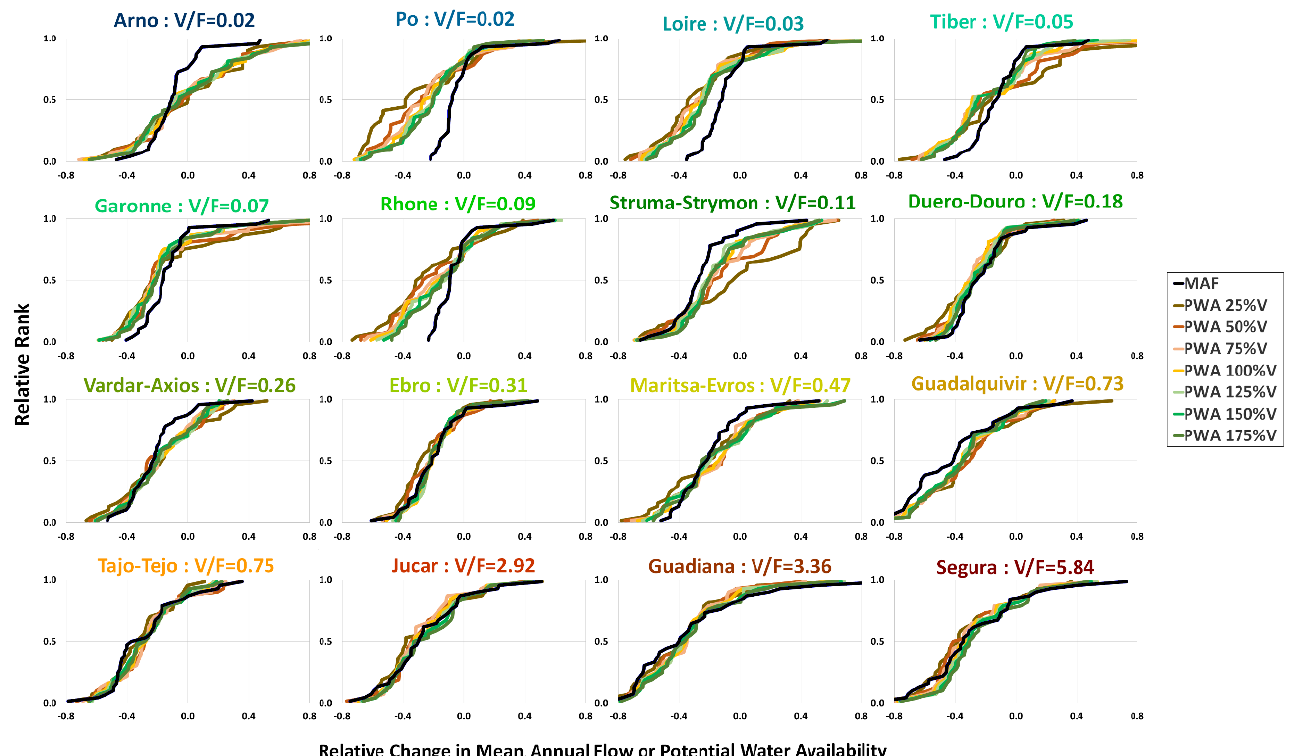
Figure 10. Probability distribution of changes in Mean Annual Flow ( ∆ F, in blue) and changes in Potential Water Availability ( ∆ PWA) for different storage values (color-coded, from 25% to 175% of current storage volume) in the 16 studied basins.